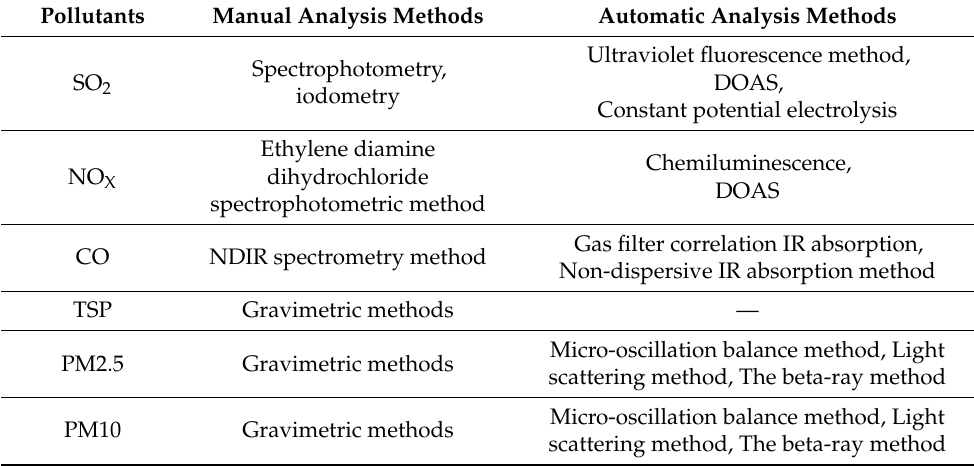
Table 4. Analytical methods for each type of pollutant. Pollutants Manual Analysis